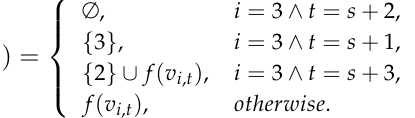
Figure 16. Sketch of f ′